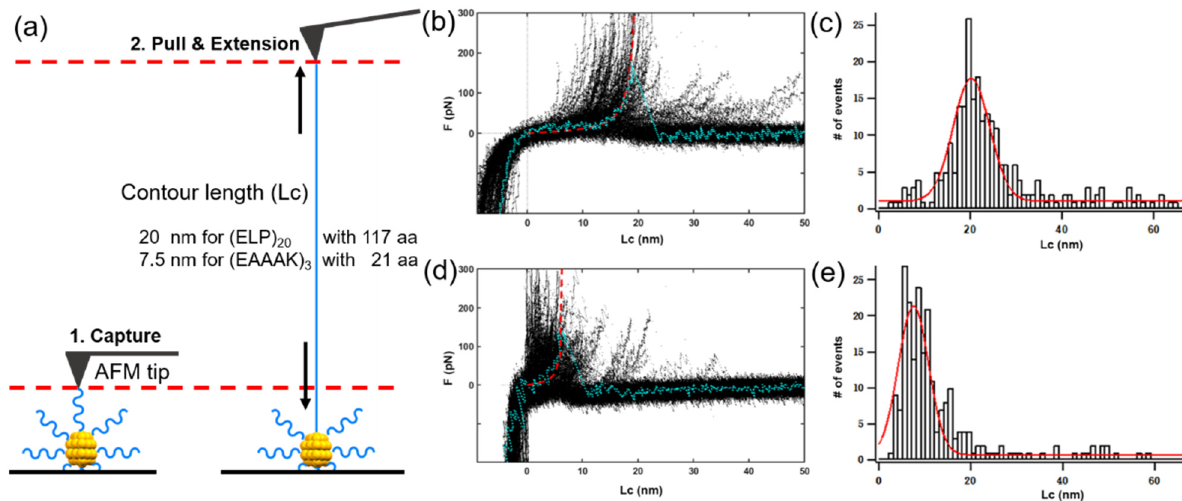
Figure 6. AFM-based single-molecule force spectroscopy (AFM-SMFS) pulling experiments. ( a ) Schematic illustration of pulling the peptide conjugated Au NCs. ( b ) The overlay of all pulling curves of peptide CCY(ELP) 20 coated on the (ELP) 20 -Au NCs. A representative curve is colored in blue. ( c ) The distribution of contour length (Lc) of (ELP) 20 -Au NCs. ( d ) The overlay of all pulling curves from peptide CCY(EAAAK) 3 coated on the (EAAAK) 3 -Au NCs. ( e ) The distribution of Lc of (EAAAK) 3 -Au NCs.